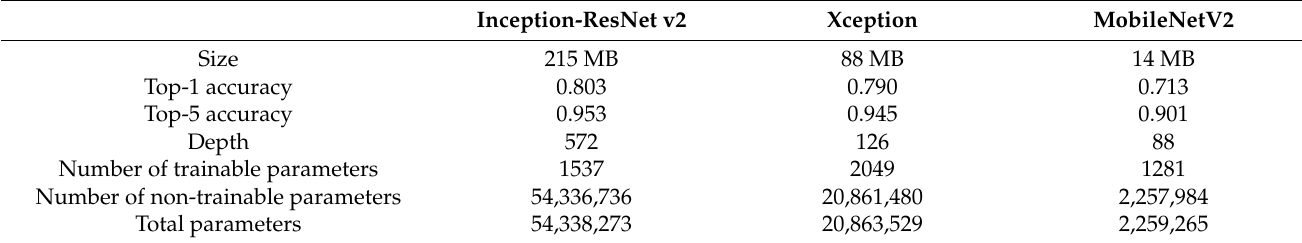
Table 1. Comparison of convolutional neural network models in terms of parameters and accuracies in the ImageNet dataset. Inception-ResNet v2